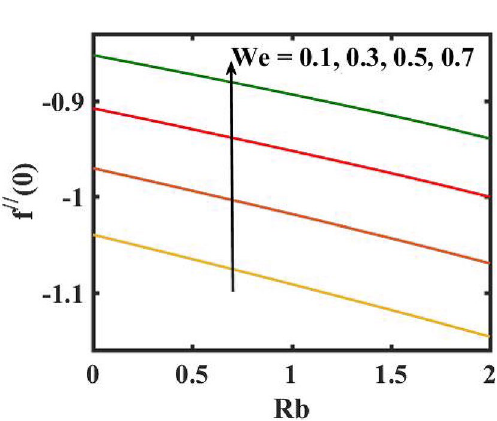
Figure 19. Encouragement We and Rb on skin friction coefficient.